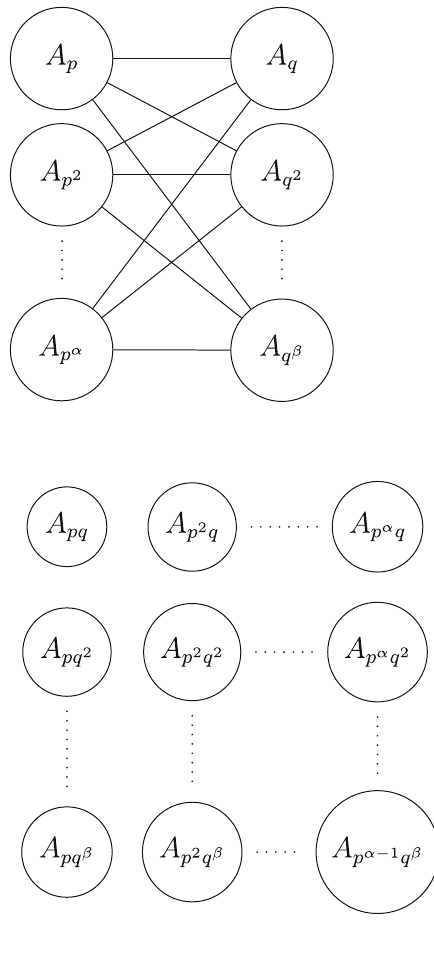
Figure 2: G 2 for n p q α β =